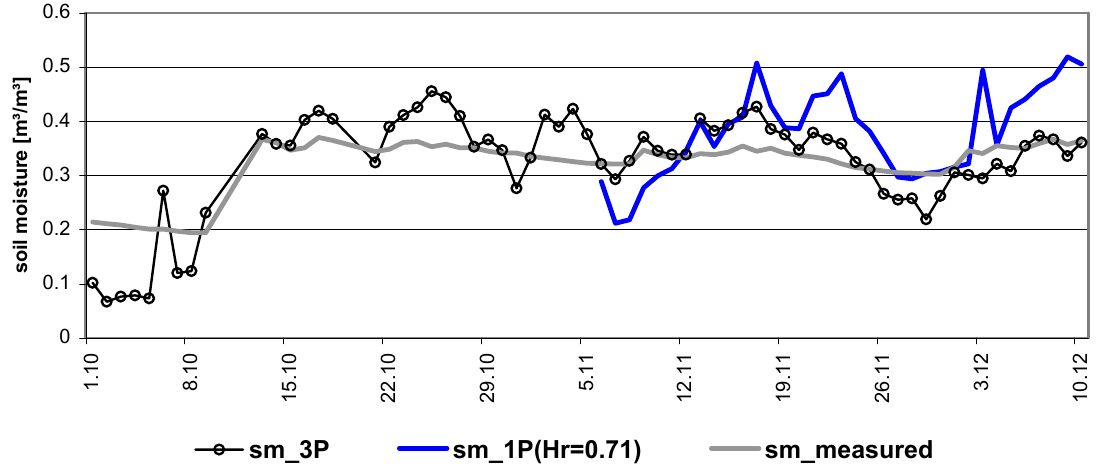
Figure 11. Comparison between the soil moisture of the 3P-retrieval (sm_3P), the 1P-retrieval (sm_1P(H = 0.71)) with a constant value of H r moisture at the location Puch.